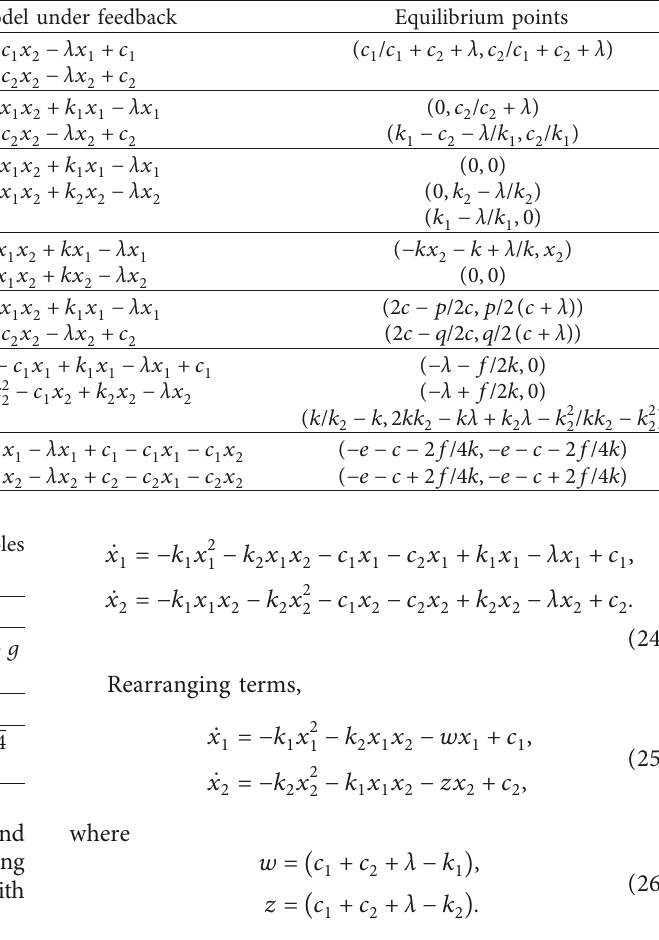
Table 1: Dynamic equations and equilibrium points for Vidale–Wolfe model (8) under different feedback advertising policies. Policy Control parameters Vidale–Wolfe model under feedback